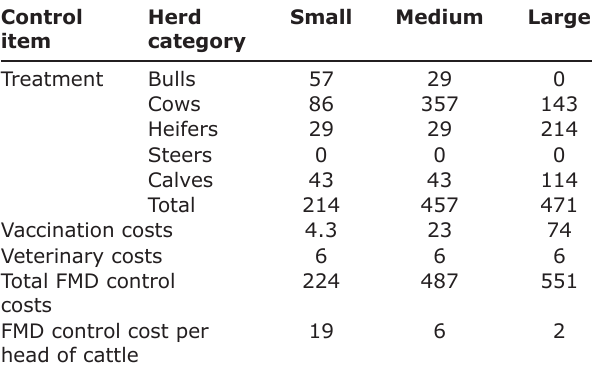
Table-10: FMD control costs in case study herds in Isingiro district. Control